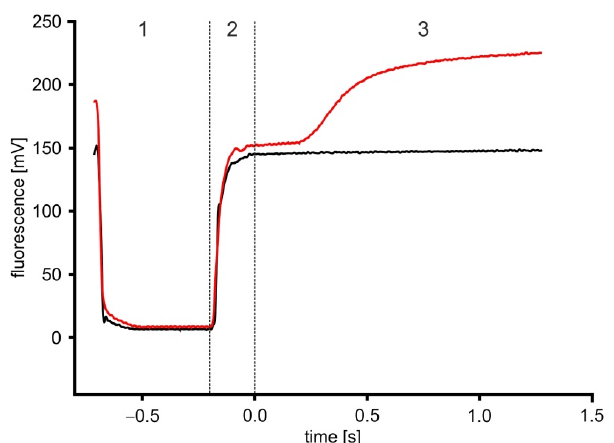
Figure 9. Diagram of typical stopped-flow fluorescence measurements. Cells were loaded with